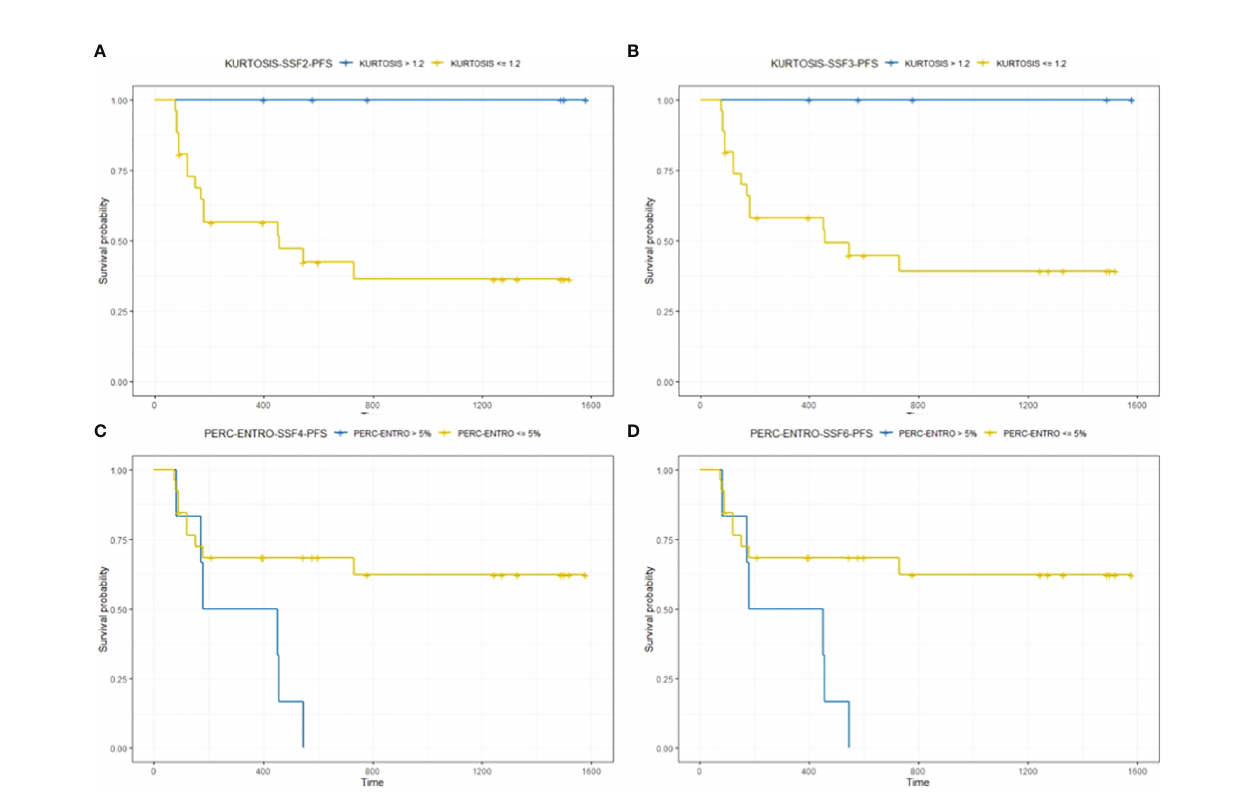
FIGURE 4 | The fi gure compares survival curves for baseline CT texture parameter kurtosis at fi ne (SSF = 2) and medium (SSF = 3) texture scales, and delta- analysis quanti fi ed Perc-ENTRO at medium and coarse scales for PFS. Patients in the good prognostic group, as identi fi ed by baseline kurtosis at fi ne (SSF = 2) and medium (SSF = 3) texture scales, had an improved median PFS of around 28 (A) and 13 months (B) respectively, compared to the respective poor prognostic group. Furthermore, the good prognostic group de fi ned using Kurtosis demonstrated zero progression. Patients in the good prognostic group, as identi fi ed by Perc- ENTRO, had an improved median PFS of around 8 months (C, D) compared to the poor prognostic